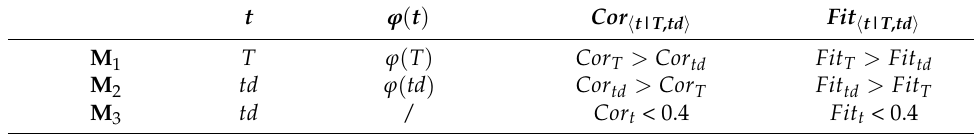
Table 2. Time-domain correlation model of regional rainfall and landslide